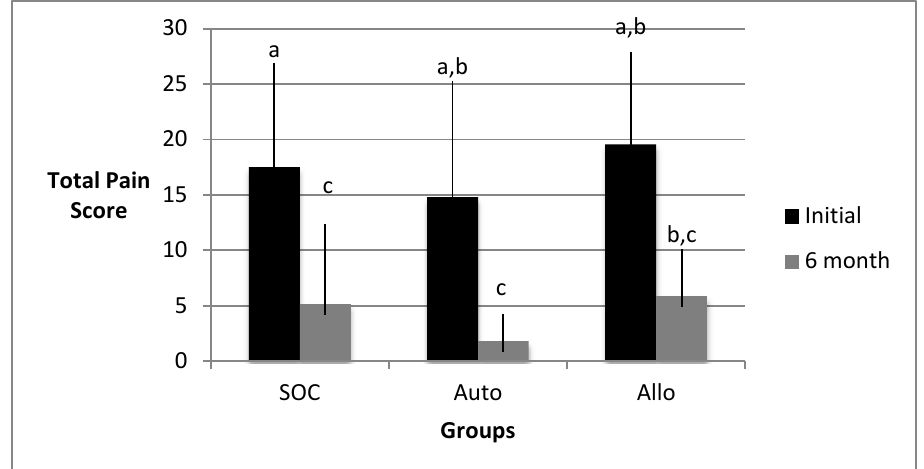
Figure 1: Comparison of pain scores between initial and follow-up assessments. Average score of canine brief pain inventory questionnaire for each treatment group’s pain score is indicated at initial assessment (black), and at 6-month follow-up assessment (grey). The x- axis is each treatment group, and the y-axis is the average score of owner assessment of patient pain calculated by answering four questions. (0= no pain, 10= extreme pain) The highest (worst pain) possible score would be forty. Treatments consisted of standard of care (SOC), autologous (Auto) or allogeneic (Allo) cell therapies. Letters above columns are to distinguish statistical significance. Columns labeled with the same letter indicate no statistical significance between scores. Columns that do not share a common alphabetic letter are p<0.05 and are considered statistically